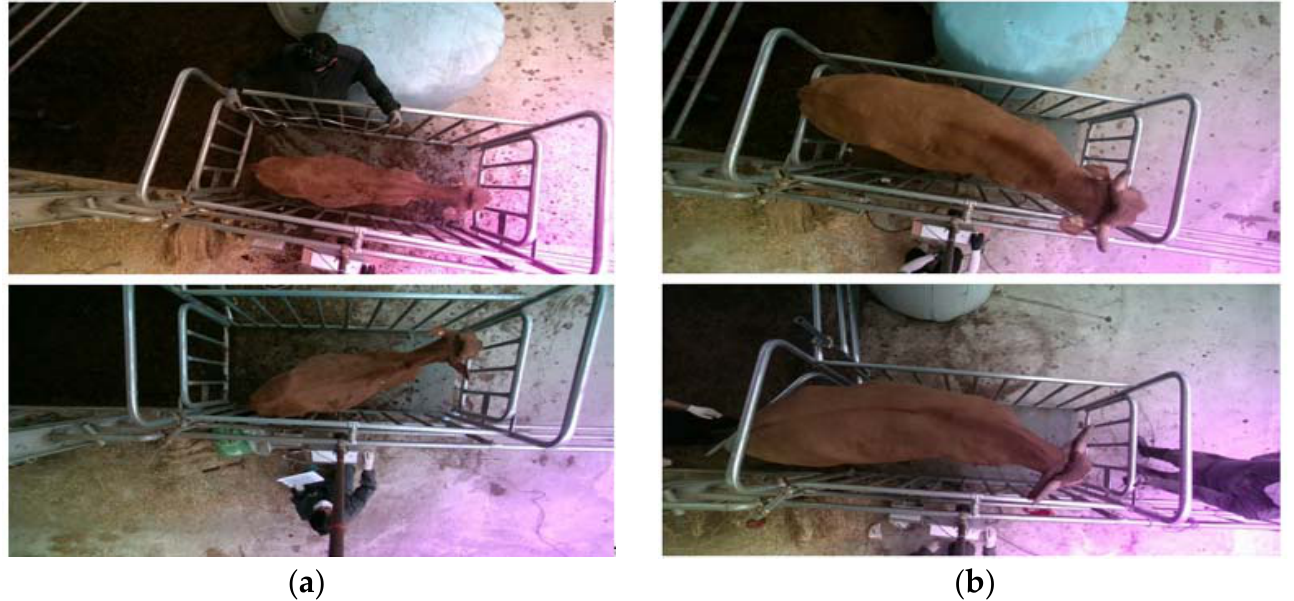
Figure 1. Sample images for male and female Korean cattle: ( a ) male; ( b ) female.